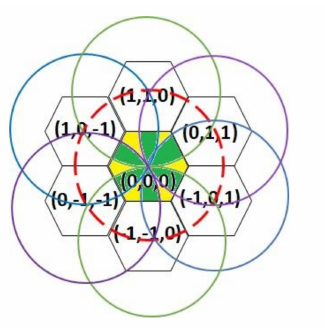
Figure 2. Neighboring sensors monitoring the cell with coordinate (0, 0,